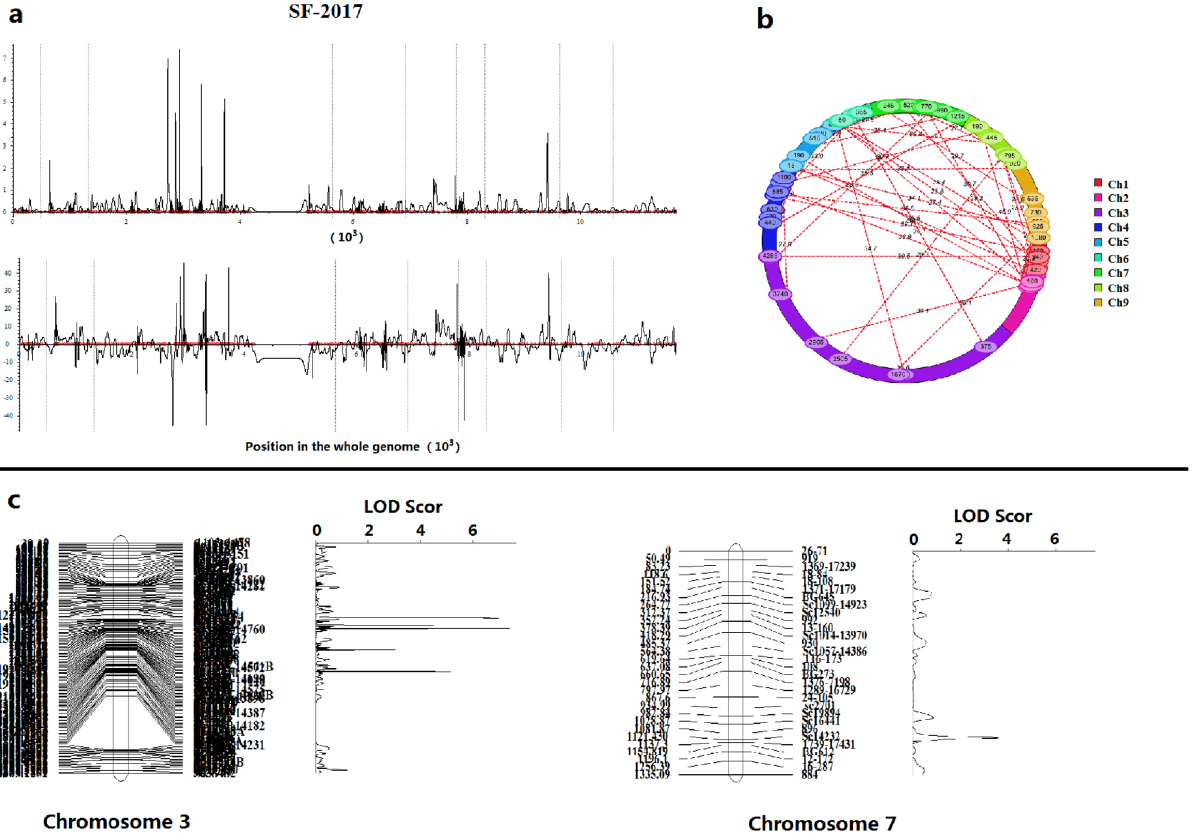
Figure 3. The profile of QTLs for SF content in broccoli florets based on 9 linkage maps ( a ), LOD values and additive effects of QTLs detected in 2017. The epistatic effects and QTL interaction effects with the environment (QE) at LOD = 3.0 ( b ). The major QTLs for biochemical variation of SF content were located on chromosomes 3 and 7 ( c